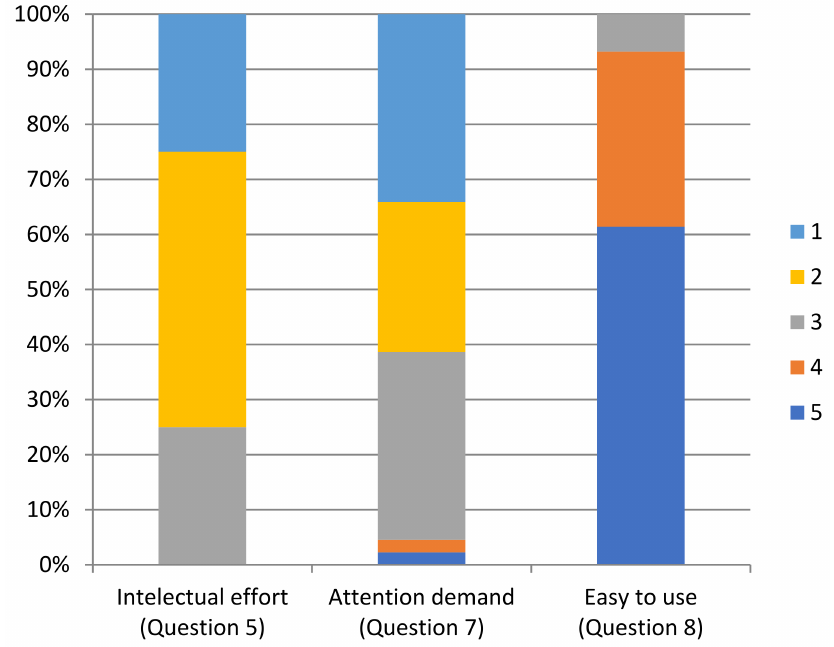
Figure 9. Results on the evaluation of the satisfaction degree of the users regarding the adaptive notification filtering component of the system [131] (percentage of respondents selecting an answer on the Likert scale, 1 for total disagreement, and 5 for total agreement with the questionnaire item; Q5. Interaction with the application requires a high intellectual effort, Q7. The information displayed was difficult to read, Q8. I think that the display responded quite quickly to the information updates).